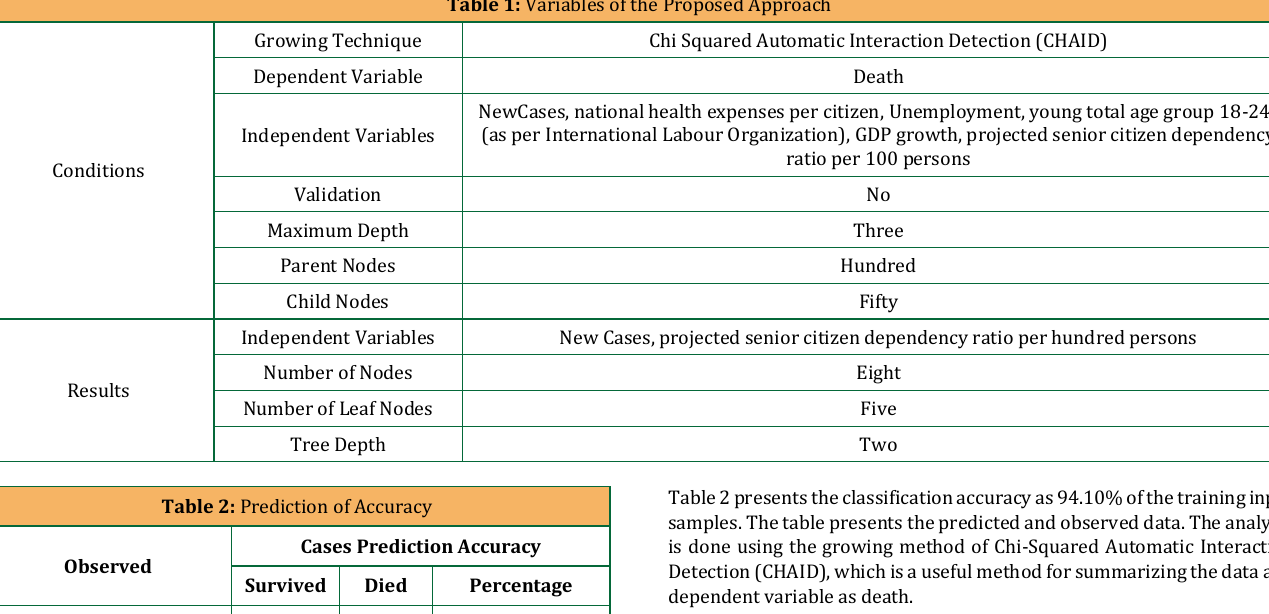
Table 1: Variables of the Proposed Approach